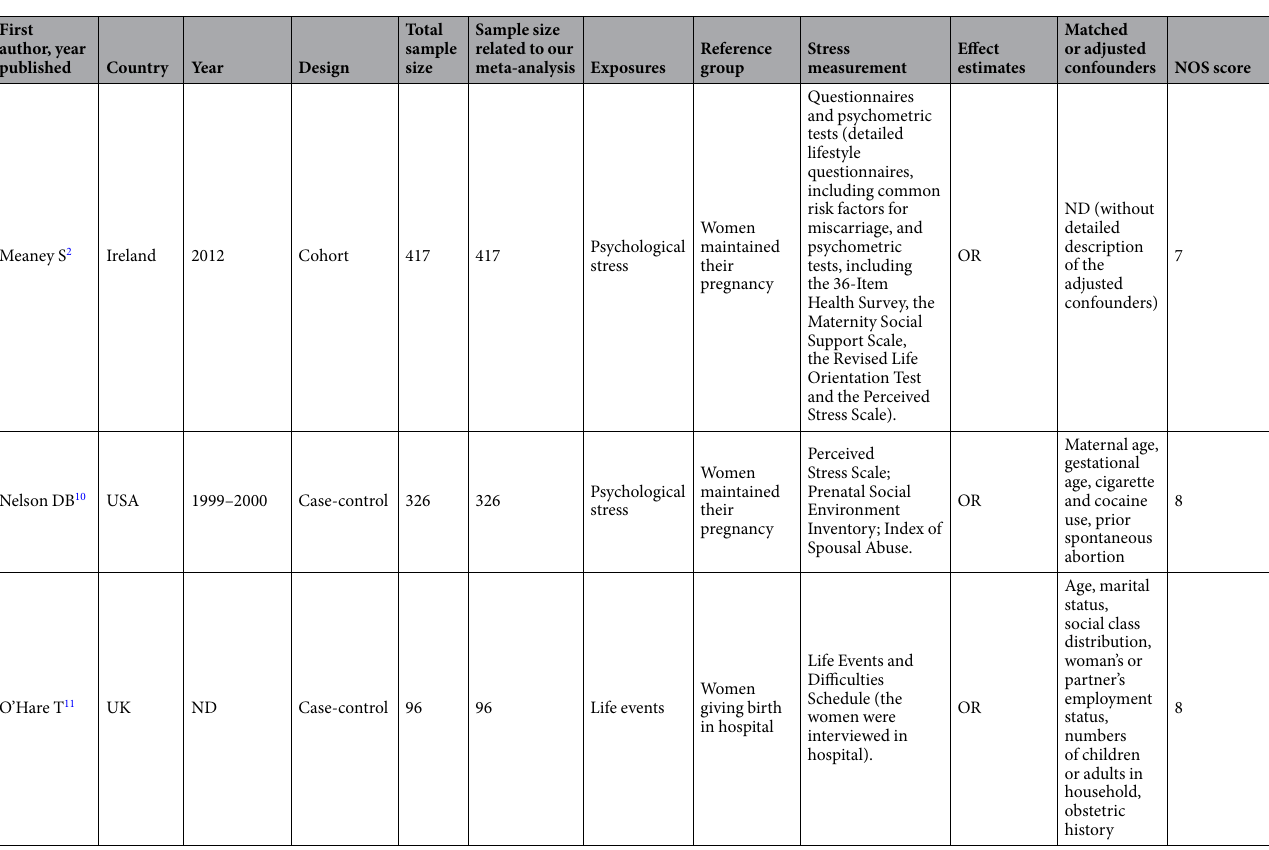
Table 1. Characteristics of all studies included in the systematic review. Note: NOS: Newcastle-Ottawa Scale; OR: Odds Ratio; CI: confidence interval; ND: Not Described; BMI: Body Mass